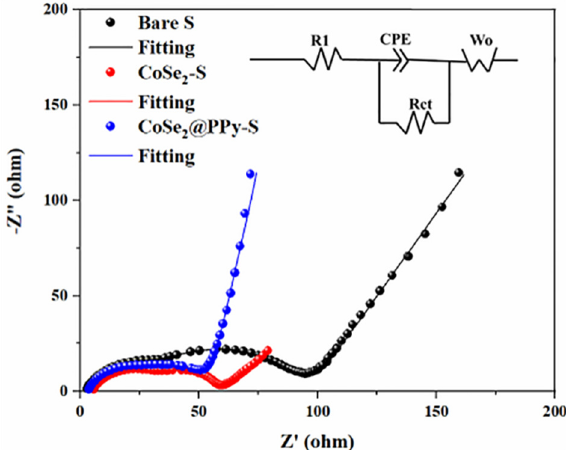
Figure 9. EIS spectra of bare sulfur , CoSe 2 -S, and CoSe 2 @PPy-S electrodes before cycling.